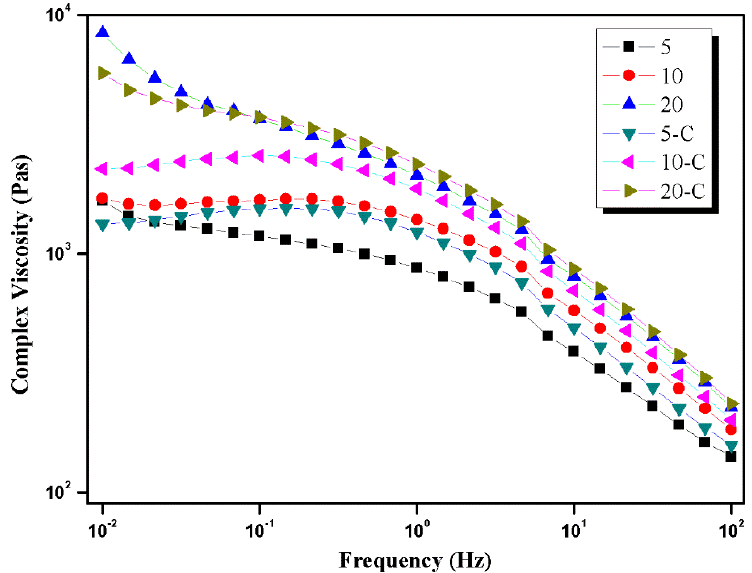
Figure 7. Complex viscosity of different blend.